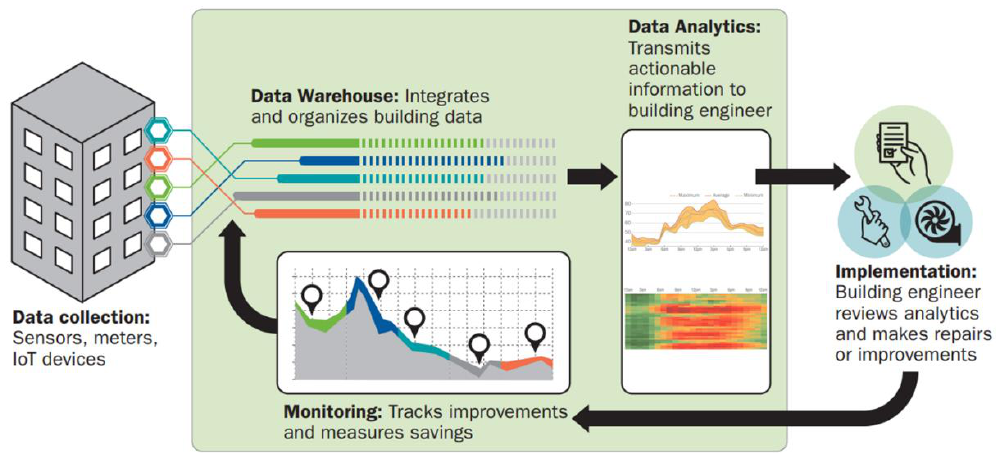
Figure 4. Leveraging building analytics tools into MBCx.